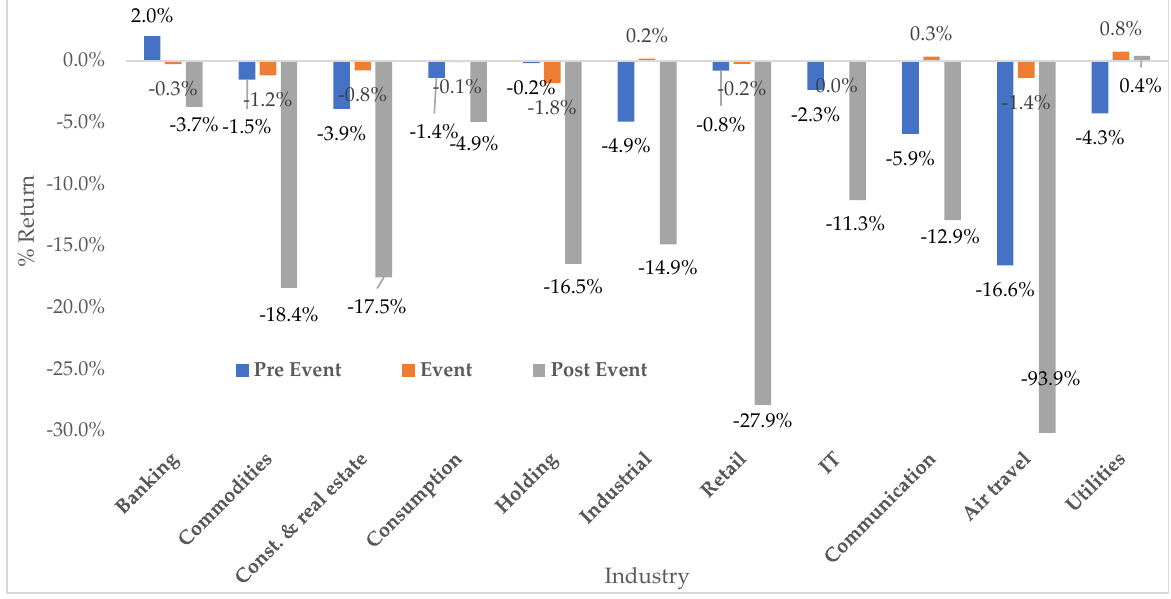
Figure 9. Cumulative abnormal returns for industries (average of the three methods).